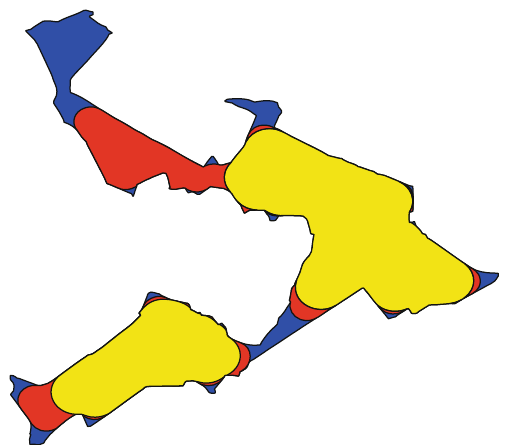
Figure 5: Numerical example illustrating the three-phase con fi guration of gas (yellow region), oil (red region), and water (blue region) after the second iteration step in the extracted pore space from Bentheim